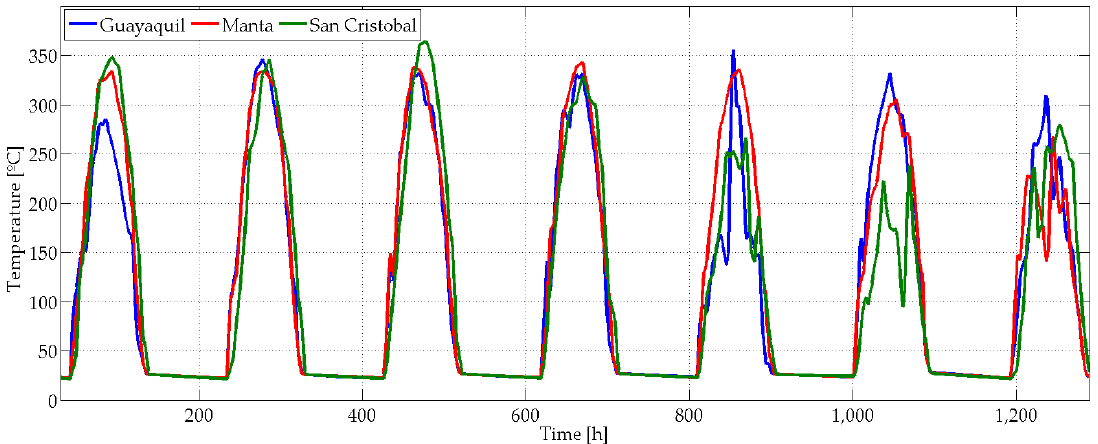
Figure 13. The Heat Transfer Fluid (HTF) Outlet temperature from the solar collector field seven days for the selected sites of Ecuador.